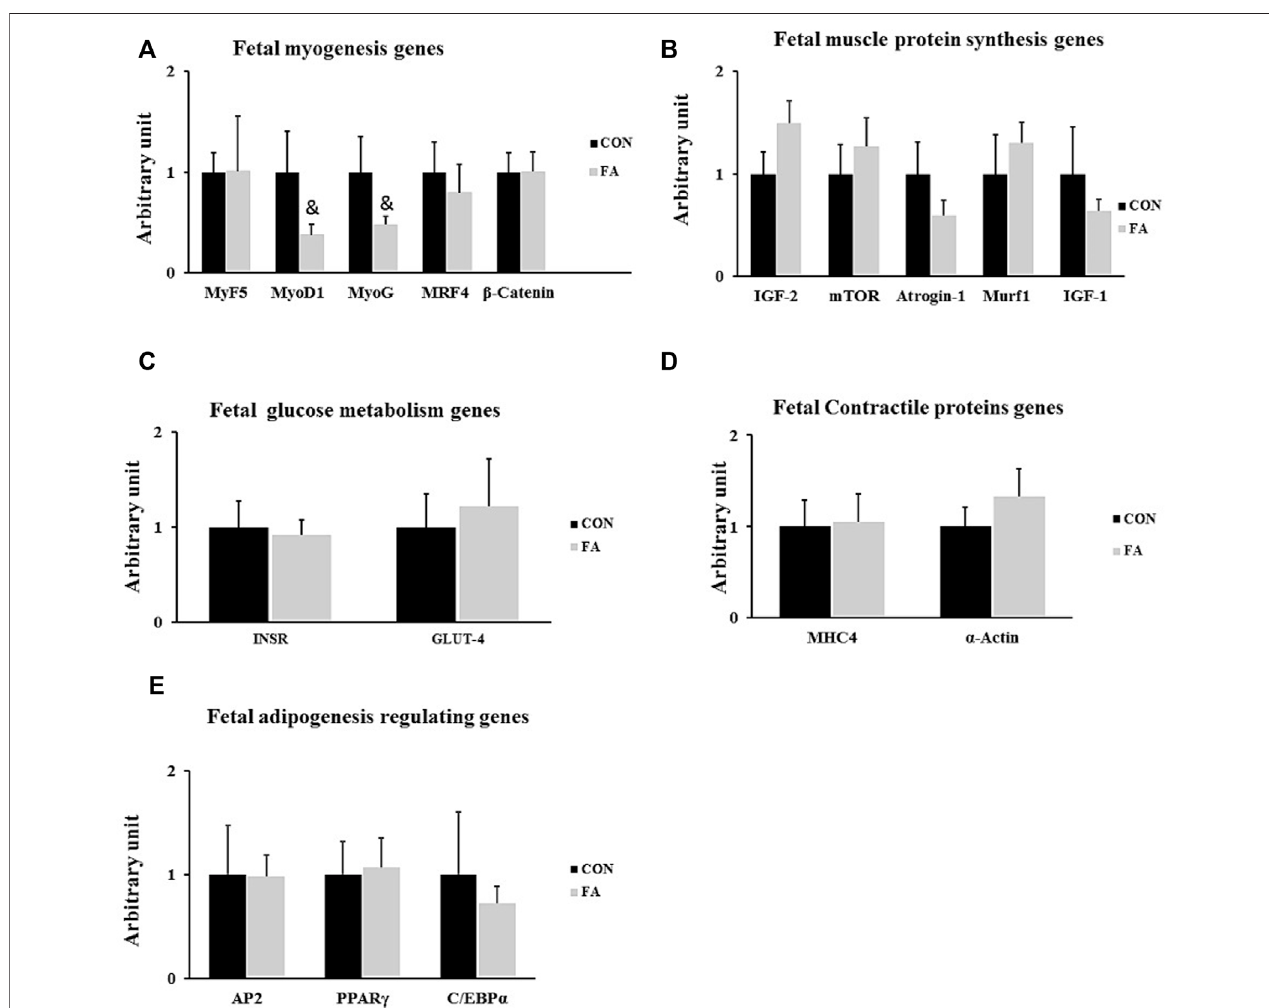
FIGURE 2 | Effect of maternal intake of EPA/DHA on fetal genes regulating myogenesis, muscle protein synthesis, glucose metabolism, muscle contraction, and adipogenesis on day 13 of gestation. The mothers were assigned to two groups, one received control diet (CON) and the other was fed EPA/DHA enriched diet (FA) (A) qPCR analysis of genes regulating myogenesis (B) qPCR analysis of genes encoding muscle protein synthesis and degradation (C) The relative expression of glucose metabolism regulating genes. (D) qPCR analysis of genes regulating muscle contractile proteins. (E) The relative expression of adipogenesis regulating genes of fetalmusclescollectedonday13ofgestation.TheCtvaluesoftargetgeneswerenormalizedtothevaluesof18 sineachsample.Alldatarepresentasmean±SEM. p < 0.05, by Student ’ s t-test ( n = 6). The symbol (&) means tendency to signi fi cant (0.05 < p < 0.1).